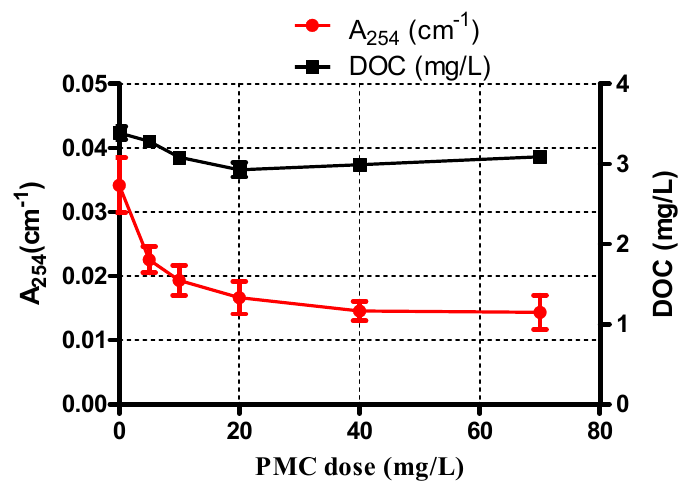
Figure 3. Removal of UV 254 and dissolved organic carbon (DOC) at the laboratory-scale using varying doses of the PMC-based coagulant (0, 5, 10, 20, 40, and 70 mg/L).